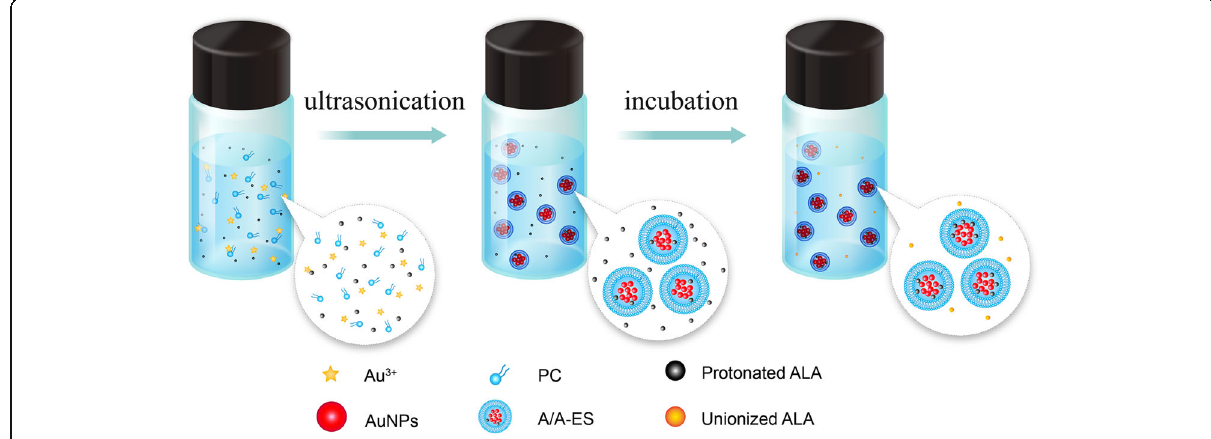
Scheme 1 Schematic diagram of preparing